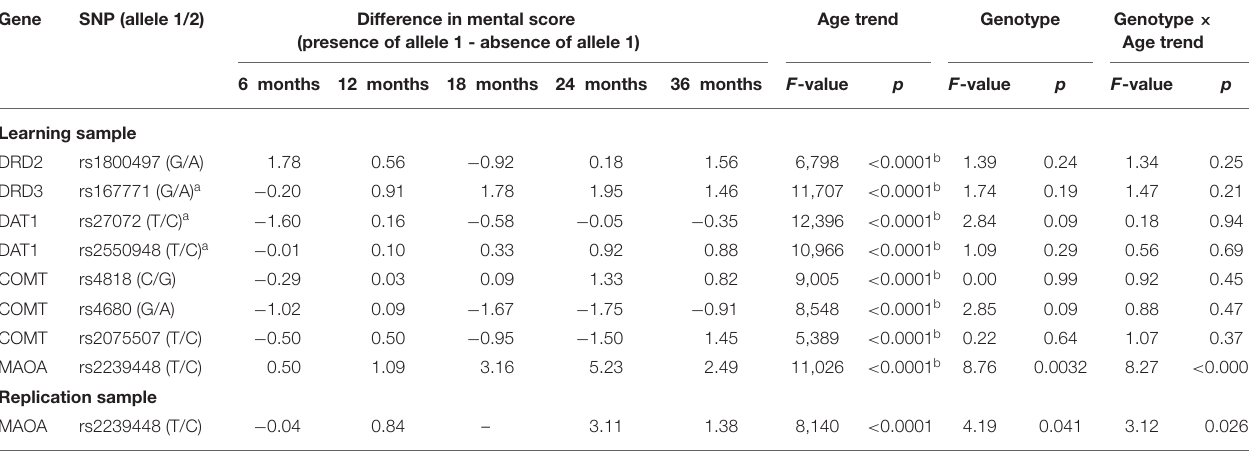
TABLE 2 | Relations of genotypes with the mental raw scores at 6, 12, 18, 24, and 36 months of age in preterm children (cohort, intervention, sex, and gestational age are treated as covariates). Gene SNP (allele 1/2) Difference in mental score Age trend Genotype Genotype × (presence of allele 1 - absence of allele 1)